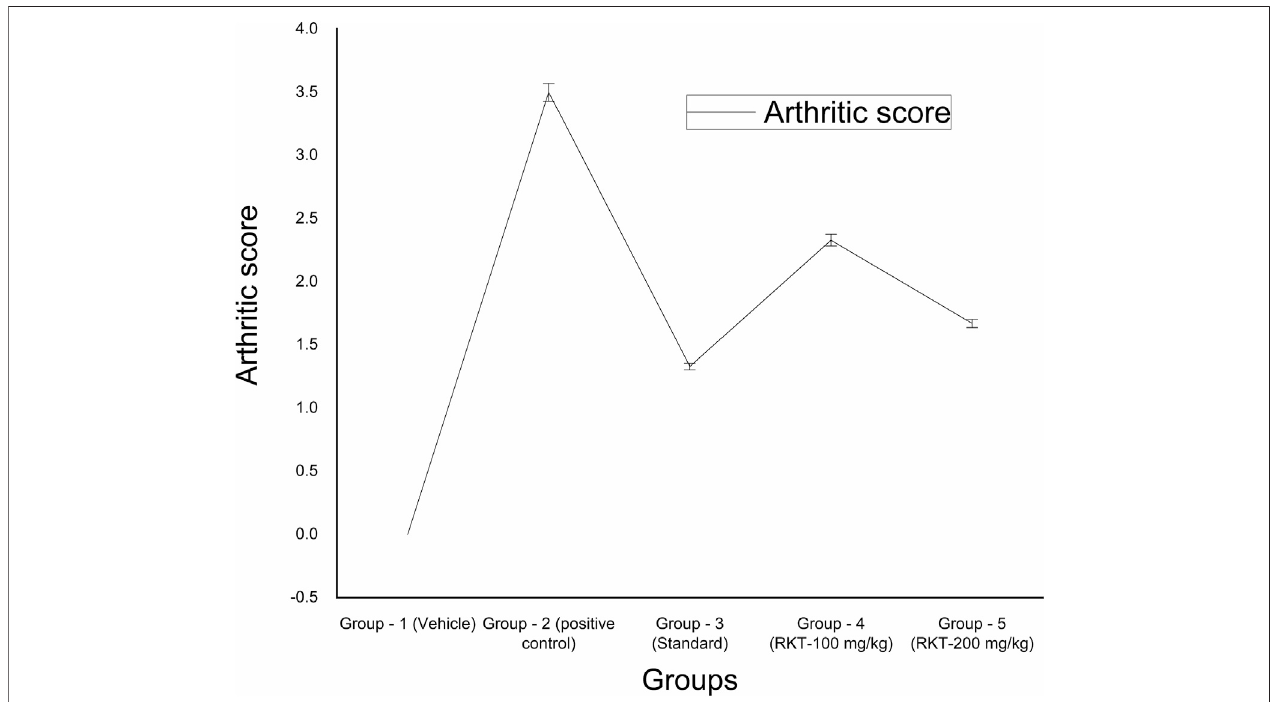
FIGURE8 | In-vivo anti-arthriticactivity (arthritic score).All the values are expressed as Mean ± SEM ( n (cid:2) 6) * p < 0.05 (G2 vs. G4); *** p < 0.001 (G2 vs. G3 and G5).